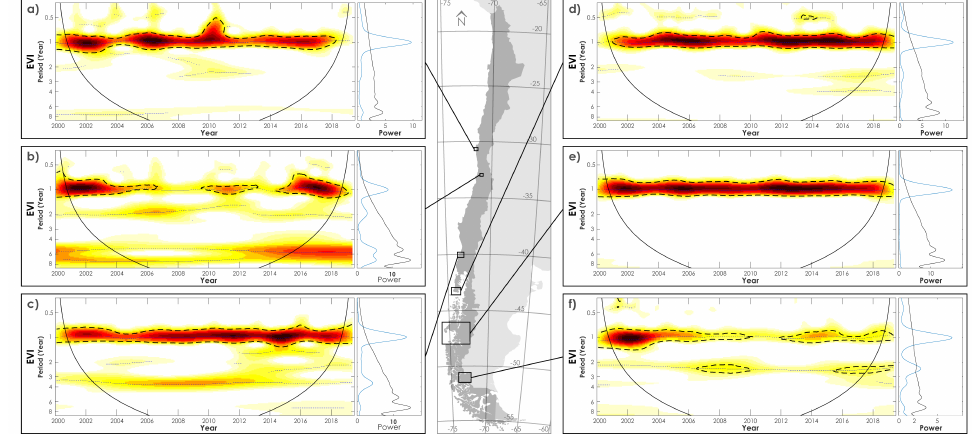
Figure 2. Wavelet analysis of EVI monthly data between 2000 and 2018 in ( a ) Fray Jorge, ( b ) La Campana, ( c ) Alerce Costero, ( d ) Tantauco, ( e ) San Rafael and ( f ) Torres del Paine. The left panels show local wavelet power spectrum. The color code for power values is from white (low power values) to dark red (high power values). The dot-black lines indicate the 95% significant areas obtained by adapted bootstrapping [57] and the cone of influence (bold-black lines) indicates the wavelet domain where computations are not influenced by edge effects (see [56]). The right panels show the global wavelet power spectrum for the period examined (2000–2018) with the black line showing a 95% confidence interval obtained by adaptive bootstrapping (note that they have different scale for better